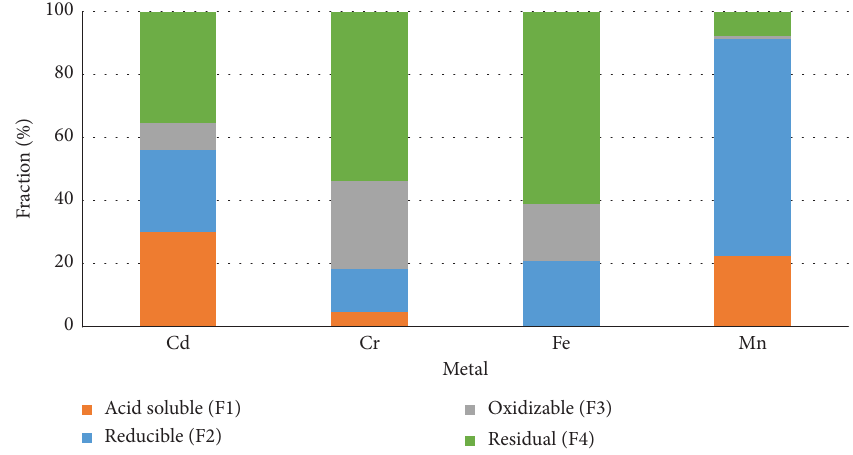
Figure 2: Percentage fraction of selected metals in soils from the study